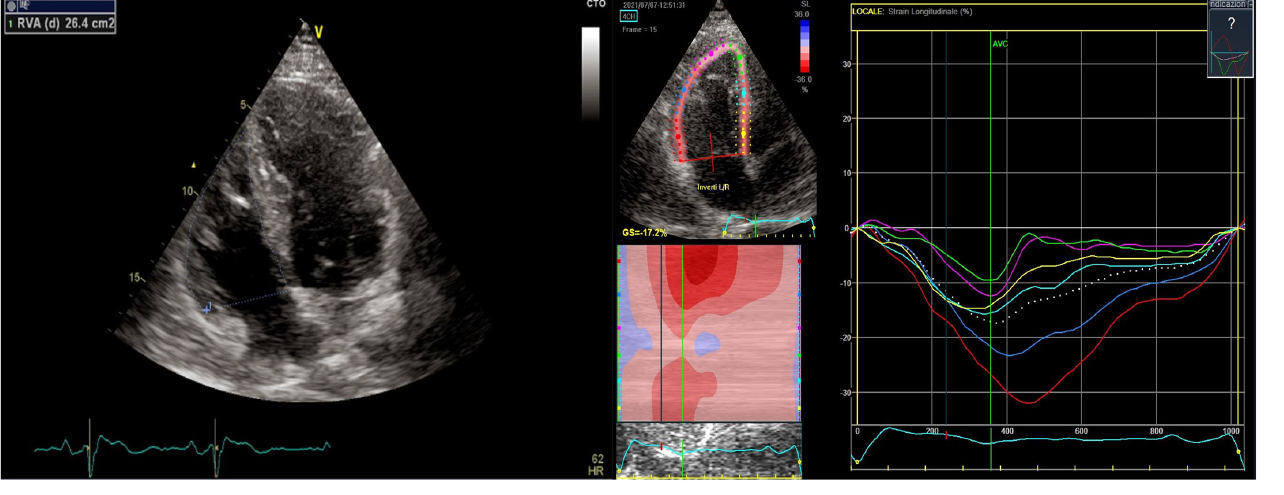
Figure 3. Right ventricular echocardiography showing a dilated RV and slightly abnormal RV strain values .